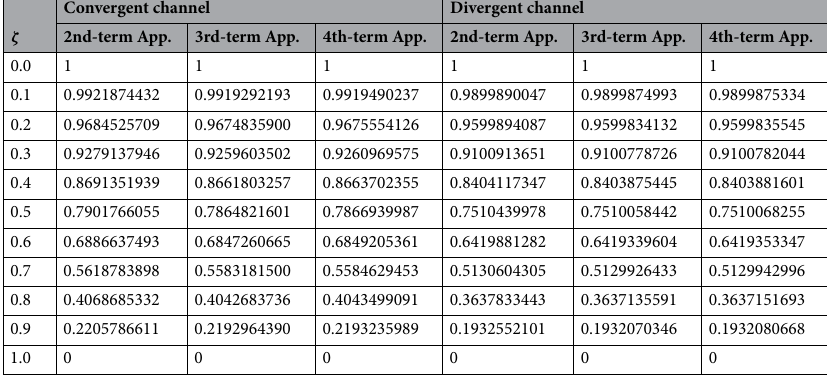
Convergent channel ζ